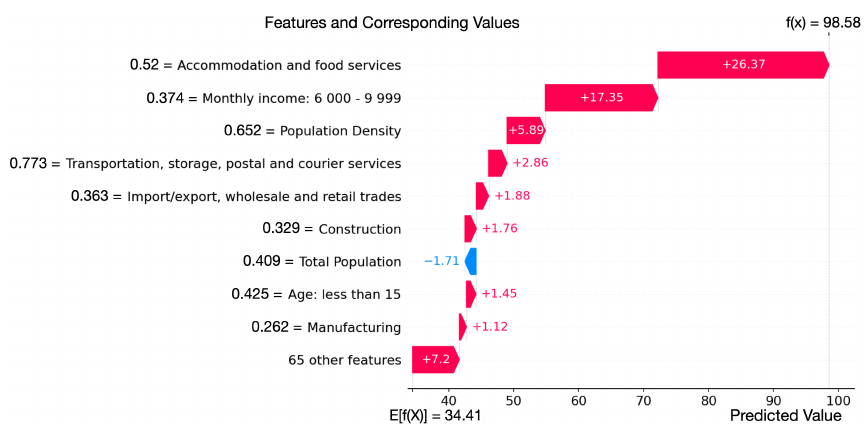
= 0.695, MAE = 10.136). ( b ) Prediction results of 1,0 = 0.830, MAE = 10.490). 1,1